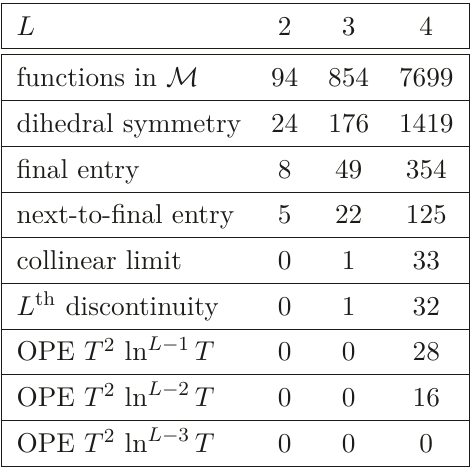
Table 3. Number of parameters left when bootstrapping the form factor E ( L ) at L -loop order in the function space M